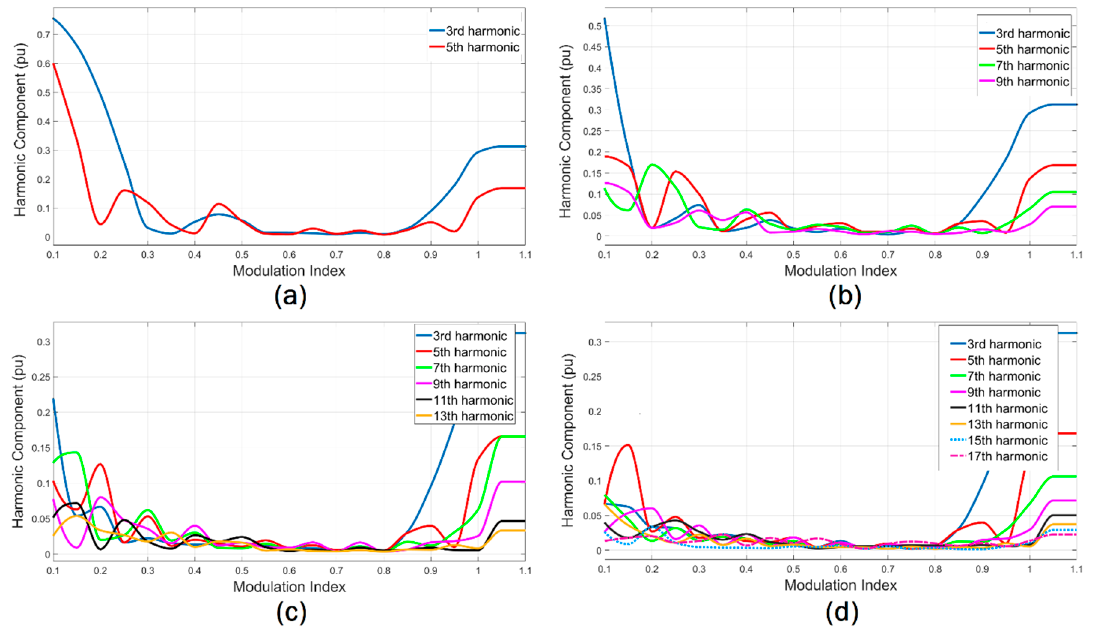
Figure 12. Variation of harmonic components depending on modulation index: ( a ) 7 − level MLI (BMO); ( b ) 11 − level MLI (GA); ( c ) 15 − level MLI (SPBO); and ( d ) 19 − level MLI (SPBO).